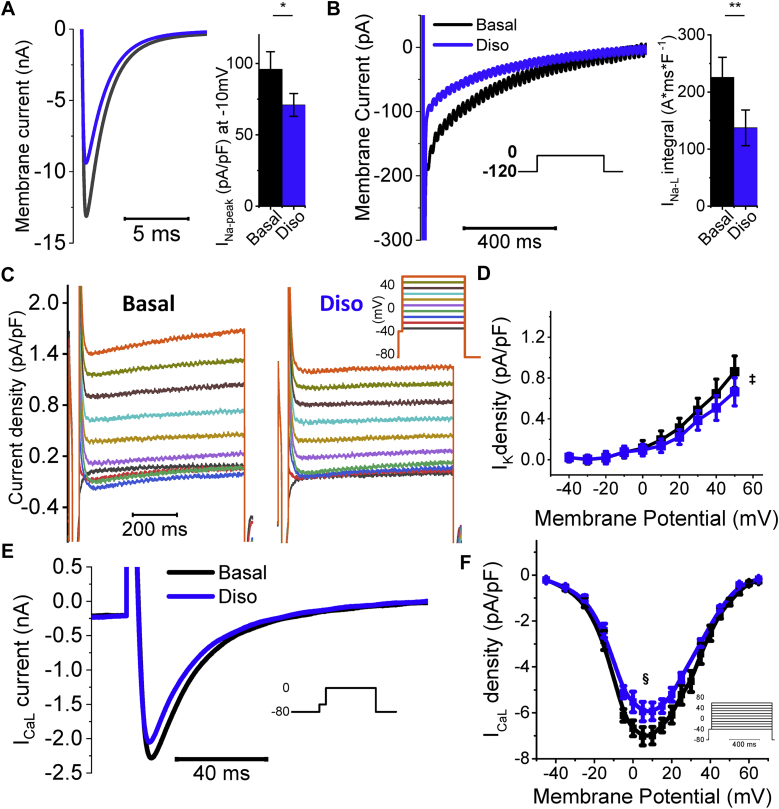
Effects of 5 μmol/l Disopyramide on Ion Channels(A, left) Representative peak Na current traces elicited at −10 mV from −120 mV resting potential, in a hypertrophic cardiomyopathy cardiomyocyte in the absence (black) and presence of disopyramide (Diso) (blue trace). (Right) Average peak Na+ current (INa-peak) density at −10 mV; effect of disopyramide. (B, left) Representative late Na+ current (INaL) traces elicited at -10 mV from −120 mV resting potential, in the absence and presence of disopyramide. (Right) Average integral of the area of the current between 50 and 750 ms after onset of the −10 mV clamp pulse, normalized by cell capacitance, calculated in the absence and presence of disopyramide in hypertrophic cardiomyopathy cardiomyocytes. (A,B) Mean ± SEM from 22 cardiomyocytes, 5 patients (ID# 14 to 18). *0.05 > p > 0.01; **0.01 > p > 0.001; linear-mixed models. (C) Delayed-rectifier K currents (IK) elicited at different voltages in hypertrophic cardiomyopathy cardiomyocytes (see inset for color codes), in the absence of disopyramide (left) and in its presence (right). (D) Average IK current density in the absence and presence of disopyramide at different voltages. Mean ± SEM from 10 cardiomyocytes, 4 patients (ID# 14, 16, 19, and 20). ‡p < 0.05 for voltages ≥+20 mV, linear-mixed models used to compare each coupled pair of values. (E) Representative L-type Ca2+ current (ICa-L) traces elicited at 0 mV from −80 mV resting voltage. (F) Average ICa-L current density in the absence and presence of disopyramide at different voltages. Mean ± SEM from 12 cardiomyocytes, 3 patients (ID# 15, 17, and 18). §p < 0.05 for voltages between −10 mV and +30 mV, linear-mixed models.